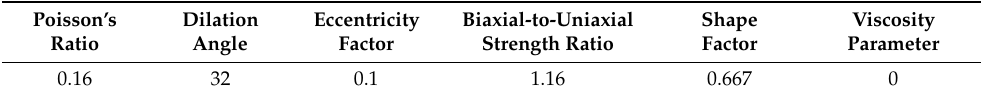
of elastic modulus ( E s ), yield strength ( f y ), and ultimate strength ( f u ) were the same as the test values given above, and the ultimate strain ( ε u ) was taken as 0.6%, respectively. The stress–strain relationship for steel is presented in Figure 9. For simplicity, a bilinear stress–strain model was used to model the stress–strain relationship of structural steel and reinforcing steel, as shown in Figure 9. The parameters of their mechanical properties mentioned above were used. For all the steel material, it is assumed that the mechanical behavior for both compression and tension is the same. Table 3. The employed material parameters for the finite element models. Poisson’s